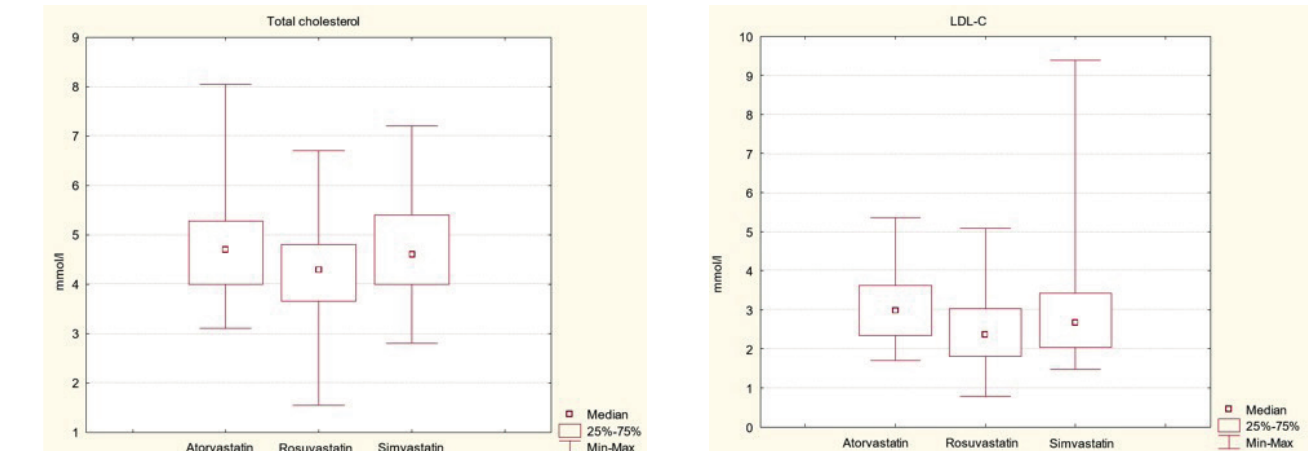
Data presented as median and [IQR].